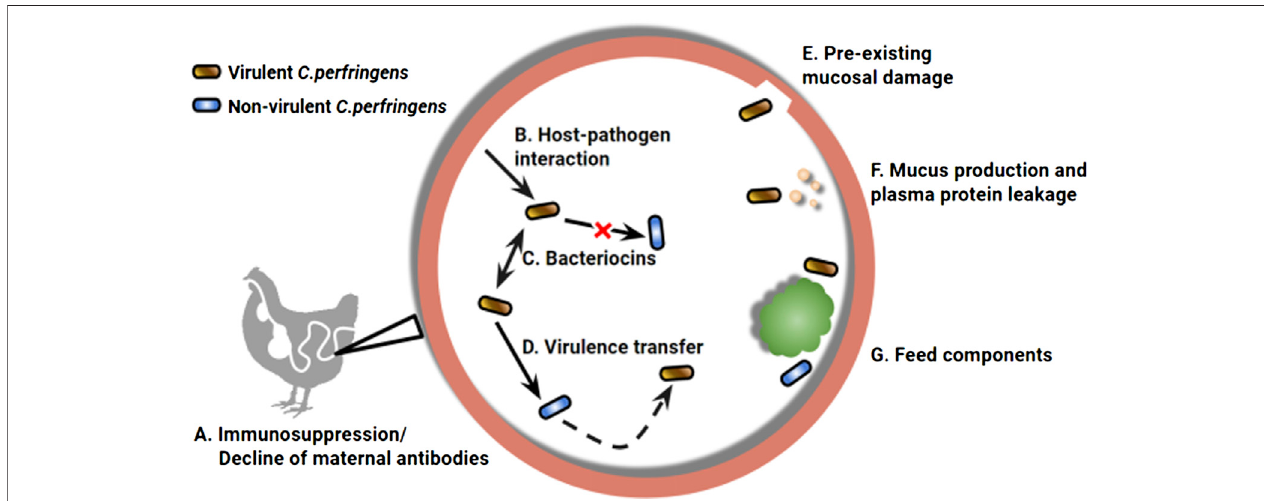
FIGURE1| Awiderangeofenvironmentalfactorsdeterminesthemanifestationofnecroticenteritis(NE)causedby Clostridiumperfringens .Chickensareathigher risk to develop NE infection with impaired immune status (A), which can result from declining maternal antibodies and/or pre-exposure to immunosuppressive factors (Lee et al., 2011). The intestine environment also plays a role in virulence modulation of C. perfringens , the fi rst example can be seen in the upregulated toxin expression when in close contact with epithelial cells (B) (Vidal et al., 2009). A complex microbiota environment, compared to a culture medium, can differentially regulate the virulence phenotype of the bacterium via inter and intra strain interactions through bacteriocin production (C) (Ohtani and Shimizu, 2015). Virulent strains are capable of producing bacteriocins that strongly inhibit non-virulent strains, as a mechanism in pathogen-commensal competition (Barbara et al., 2008; Timbermont et al., 2009). Meanwhile, non-virulent strains can inherit the virulence genes horizontally (D), leading to the emergence of new strains that are capable of causing NE (Lacey et al., 2017). Preexisting mucosal damage that exposes epithelial extracellular matrix (E), increased plasma protein leakage and mucus production (F) can provide an extra advantage for pathogenic C perfringens , which possess a stronger binding ability and mucolytic activity (Collier et al., 2008; Martin and Smyth, 2010). Diet components comprising part of the gut environment are also key risk factors associated with NE development (G). For example, feeds rich in water-soluble non-starch polysaccharides,suchasawheat-baseddiet,canincreasedigestaviscosity,prolongtransittime,andpromotepathogenretention(Annettetal.,2002;Shojadoostetal., 2012).